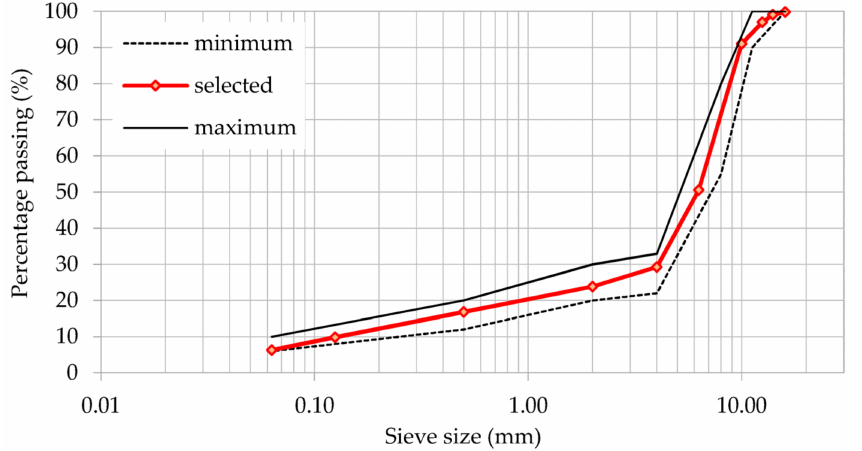
Figure 4. Selected grading composition curve for stone mastic asphalt with a maximum aggregate size of around 11 mm (i.e., SMA 11) mixtures.